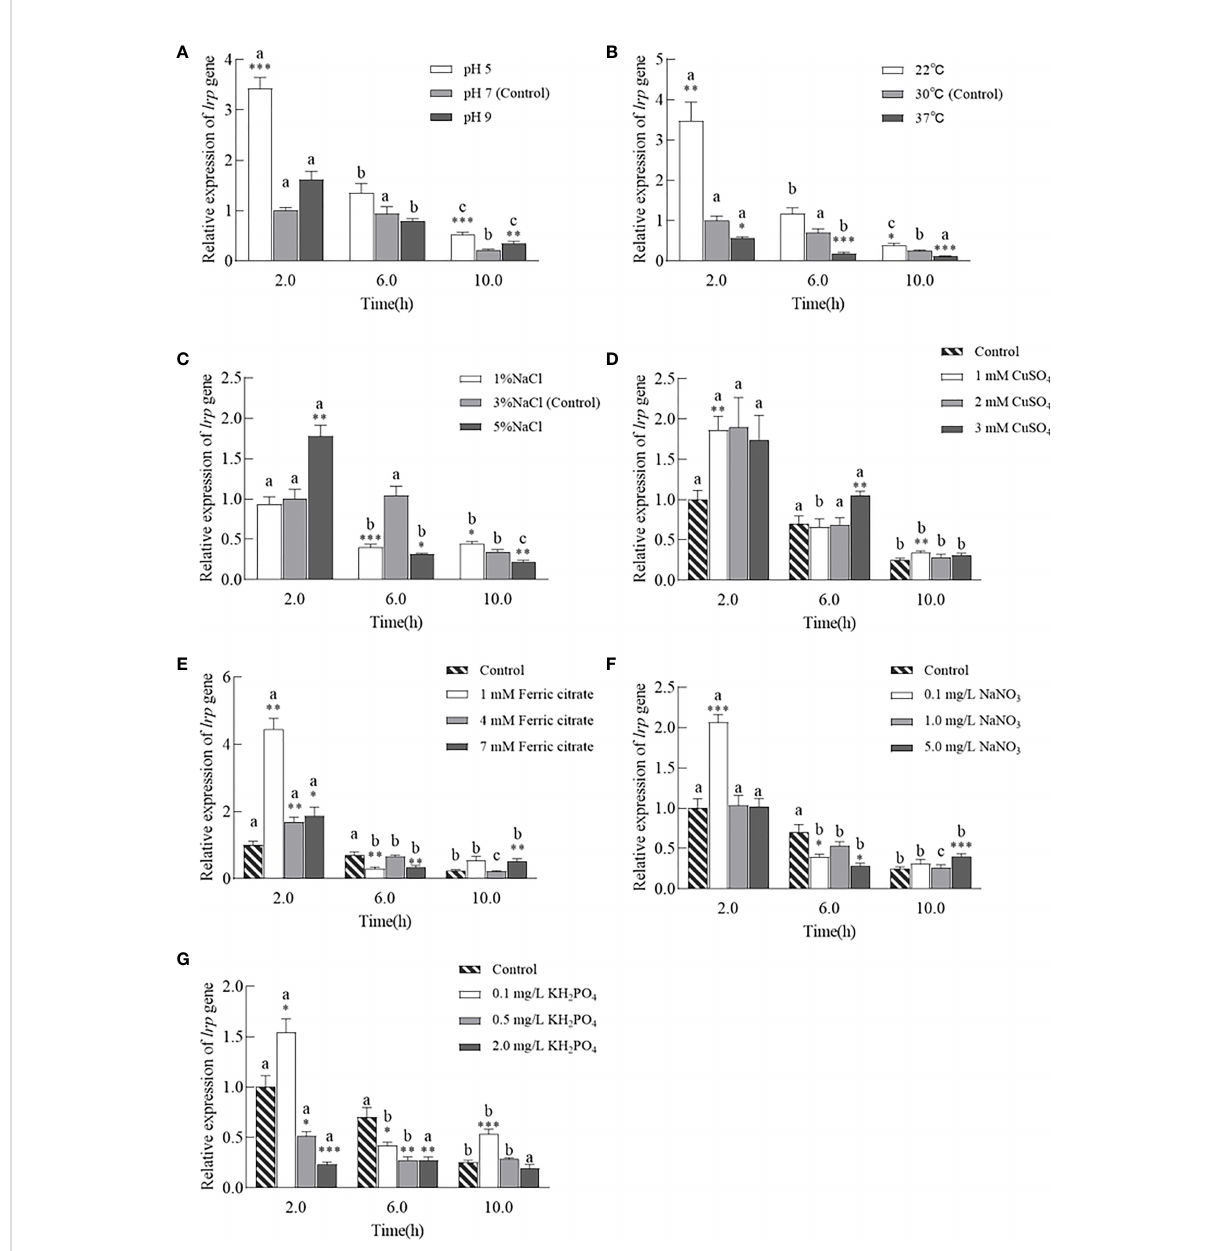
FIGURE 6 Expression pro fi les of WT strains under 7 incubate conditions. Expression levels of strains cultured in LBS with different pH (A) , temperature (B) , salinity (C) , and addition of different concentrations of copper ion (D) , iron ion (E) , nitrate (F) , phosphate (G) . Data are expressed as means ± SE relative to control group. Signi fi cant differences between control group and treatment groups at the same growth period are indicated with asterisks (*, P <0.05; **, P <0.01; ***, P <0.001). Take strains with the same culture conditions as a group and use different letters to indicate signi fi cant differences in the growth period of the same group ( P